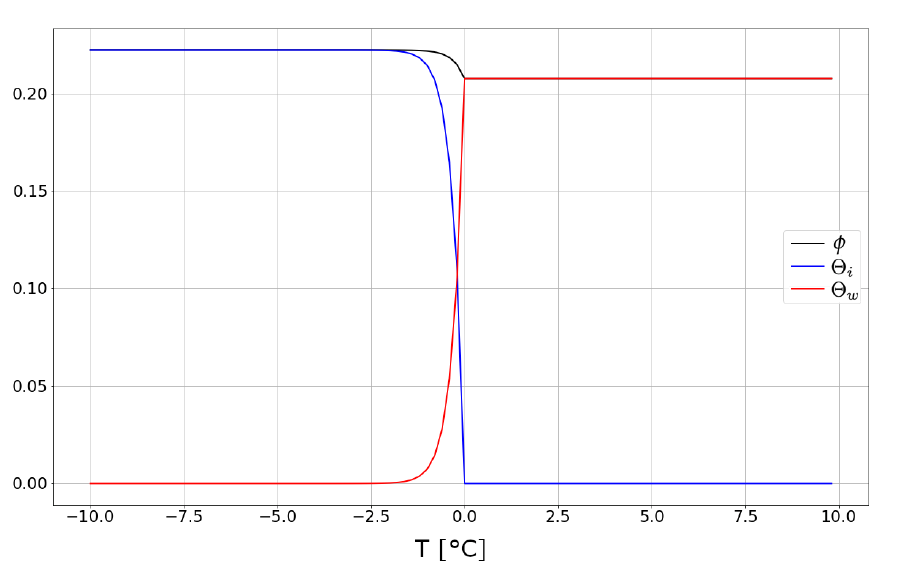
Figure 4. Illustration of water fraction volume Θ w (red color), ice fraction volume Θ i (blue color) and porosity φ (black